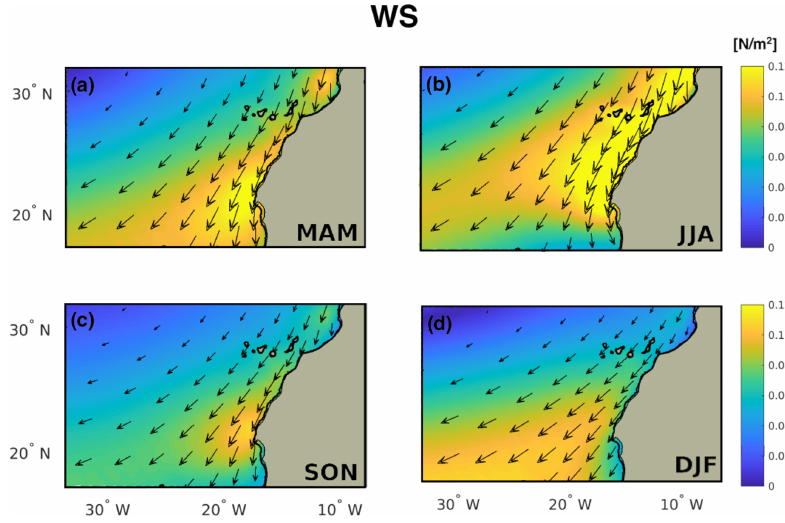
Figure B4. Seasonality of the wind